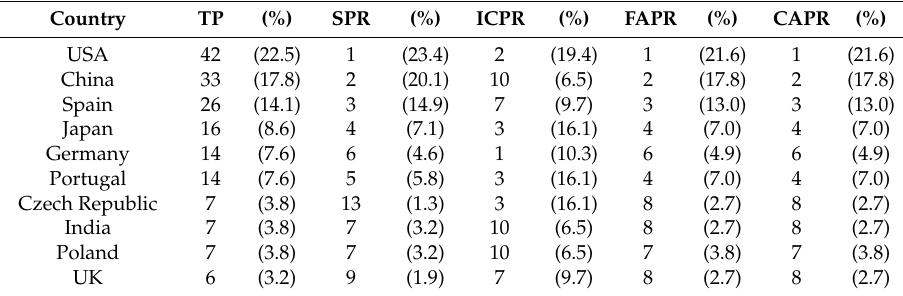
Table 3. The top 10 most productive countries.